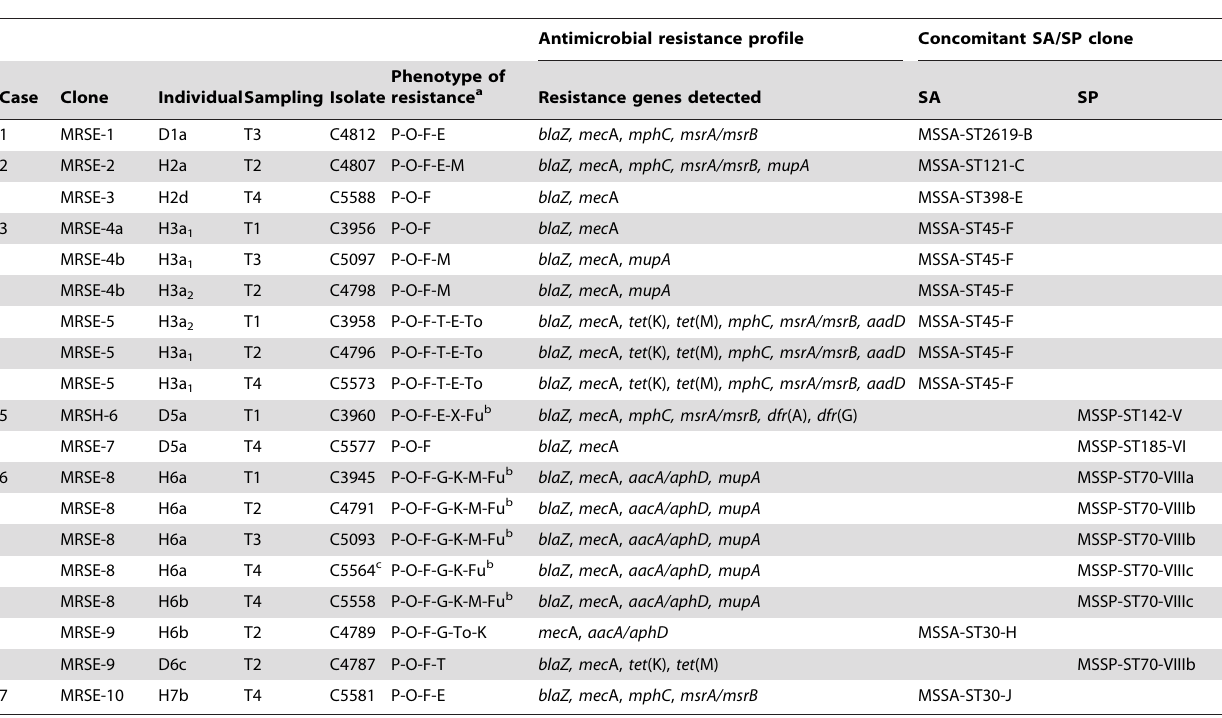
Table 3. Characteristics of the MRCoNS recovered in the SA/SP positive individuals per